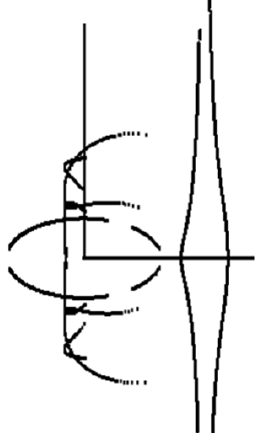
Figure 14. q = 0.5, KG = 100, and DK = 140.